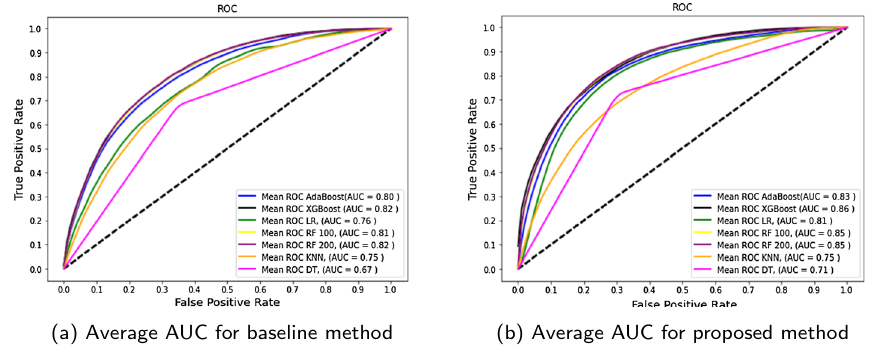
Fig. 17 Comparison of ROC curve and AUC values for all